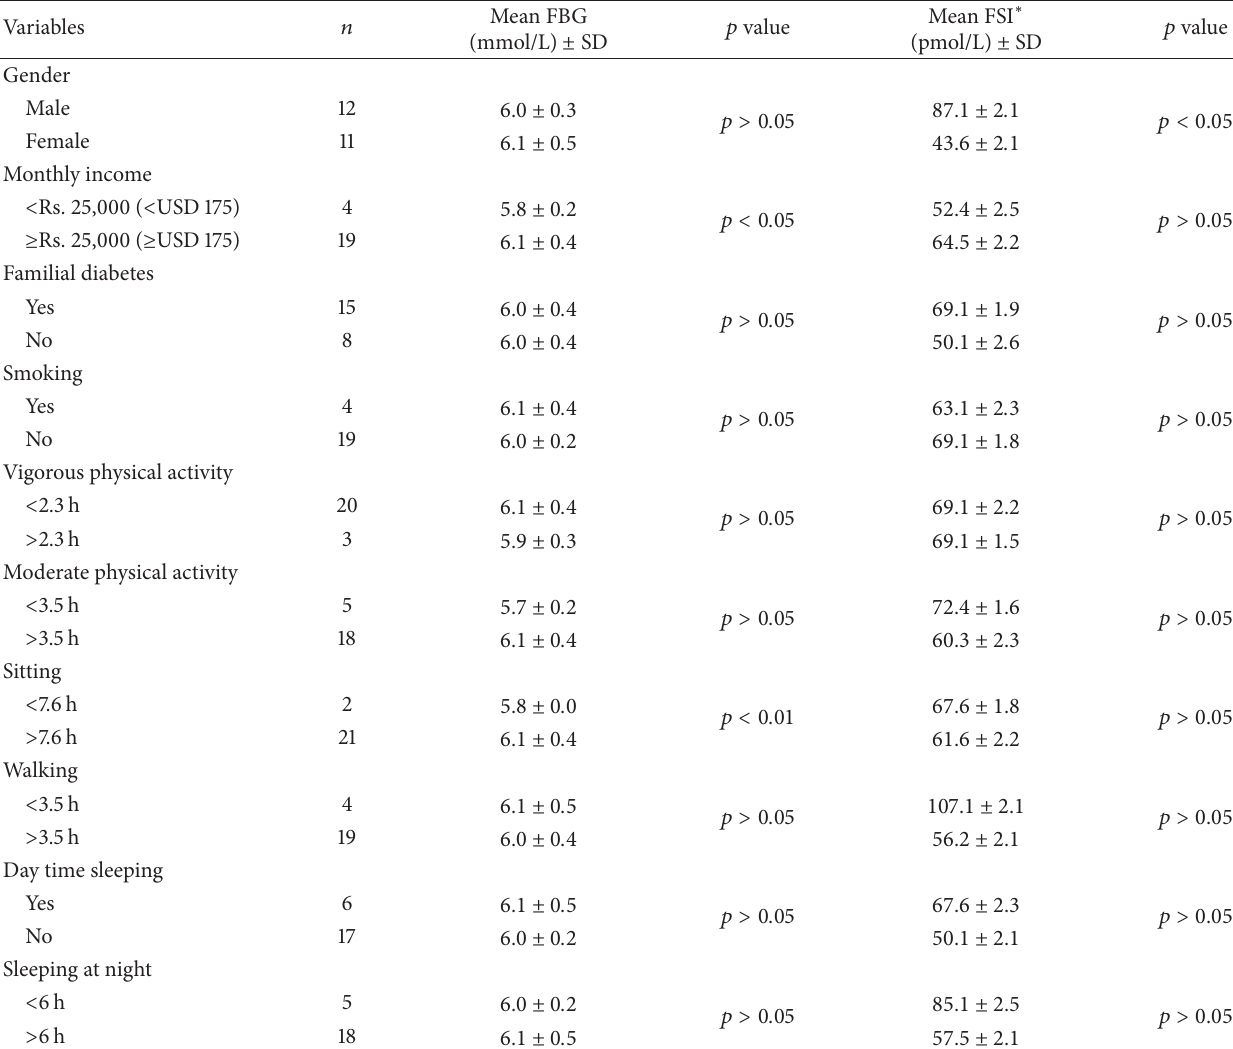
Table 5: Comparison of FBG and FSI among different groups in categorical variables in prediabetic subjects † .